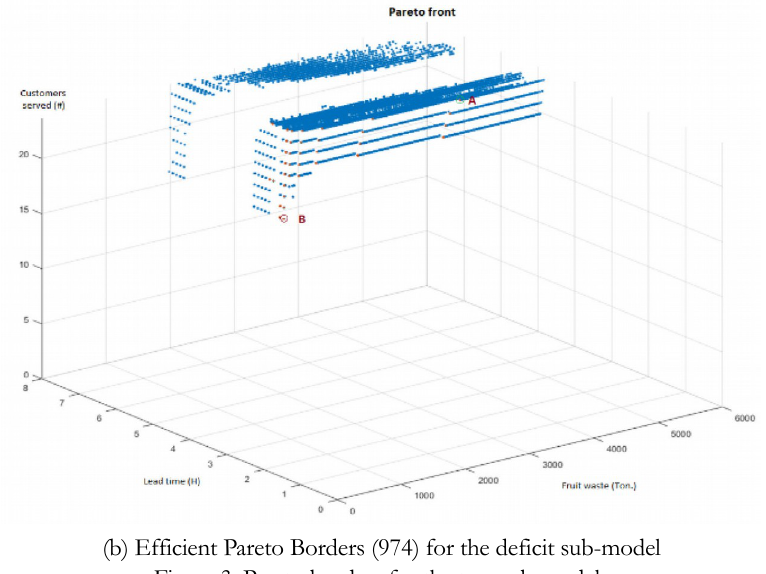
Figure 3. Pareto borders for the two